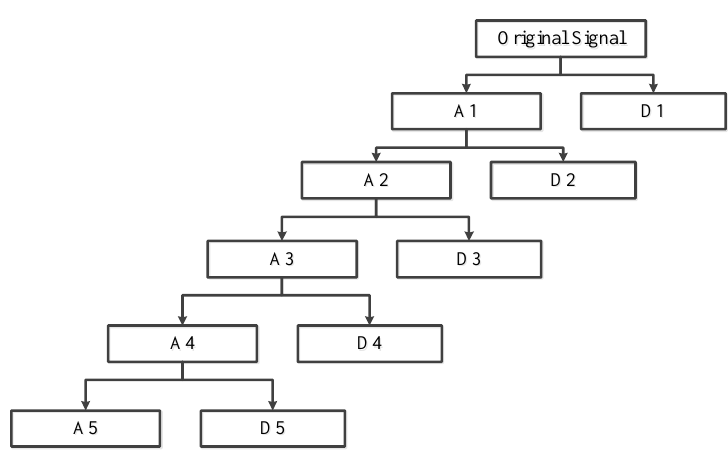
Figure 5. Five-layer SWT.